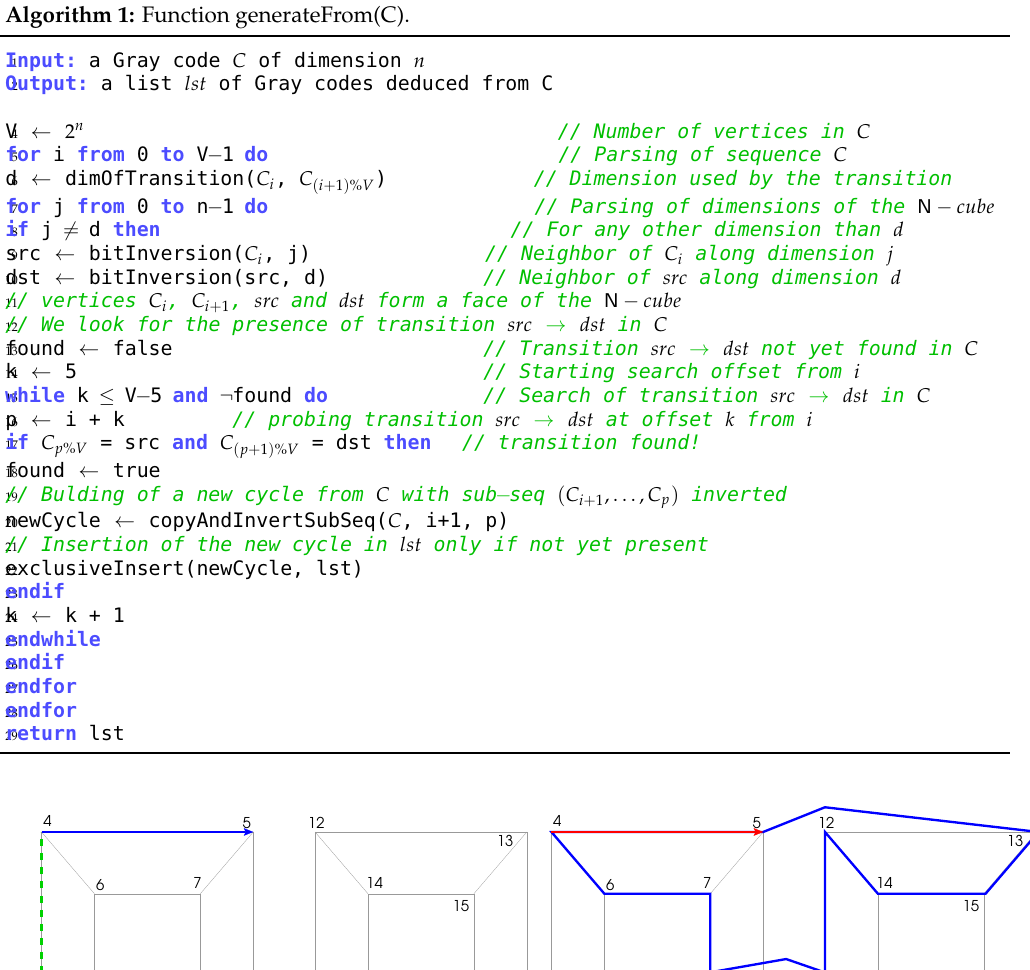
Algorithm 1: Function generateFrom(C).